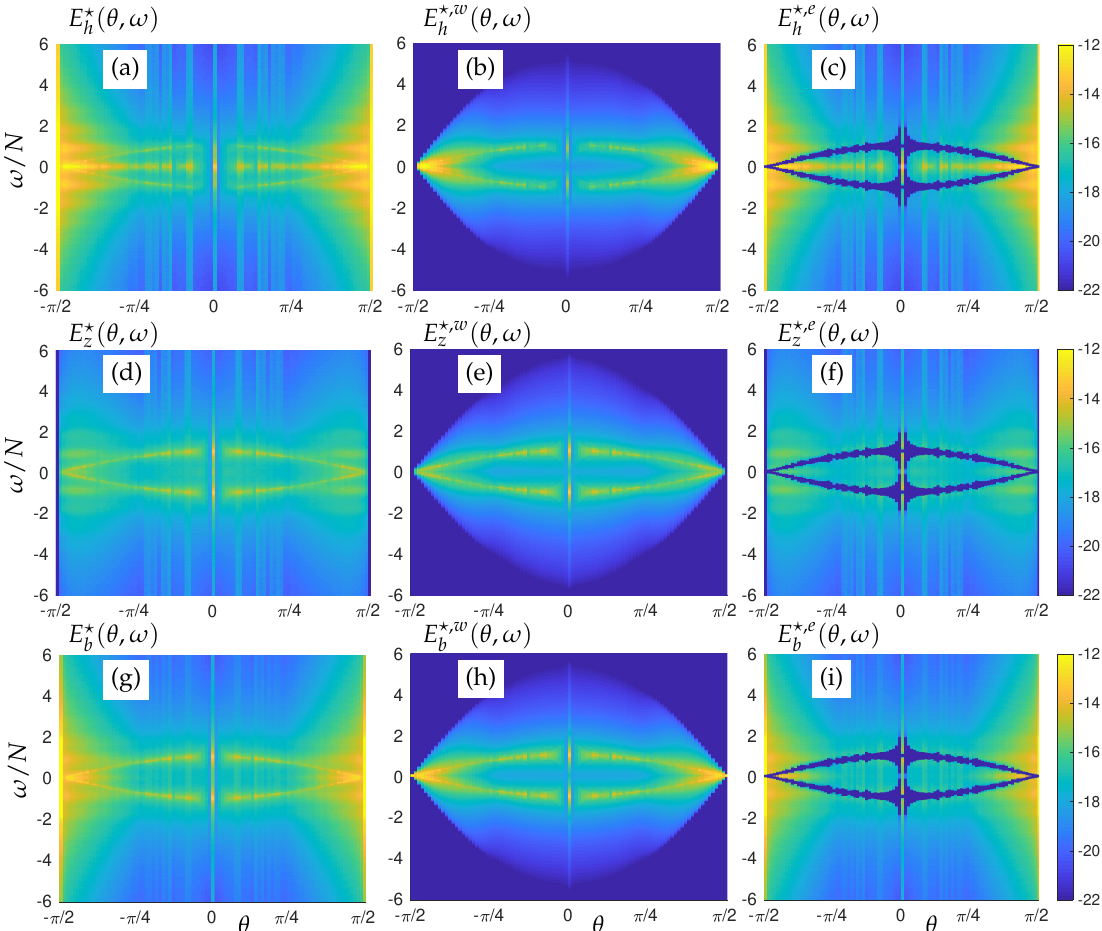
Figure 12. ( a – c ) Density of horizontal kinetic energy in the ( θ , ω ) plane; ( d – f ) vertical kinetic energy; and ( g – i ) potential energy. The left column ( a , d , g ) corresponds to the total energy, the middle column ( b , e , h ) corresponds to the filtered wave part, and the right column ( c , f , i ) to the filtered eddy part. Plots are in